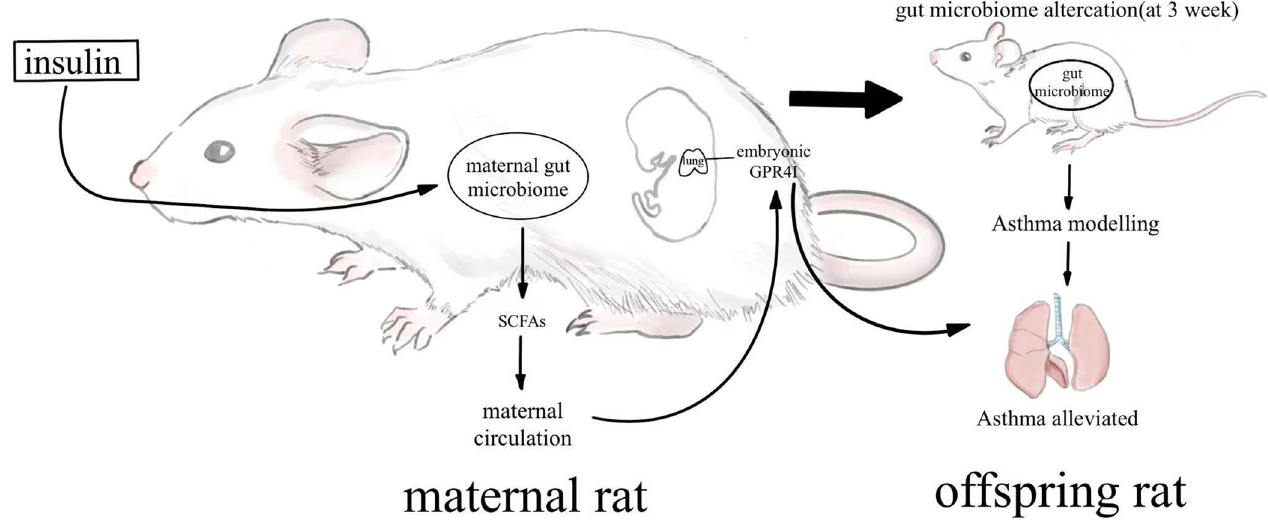
Fig 7. The influence of maternal inulin diet on gut microbiome and GPR41 expression of offspring.